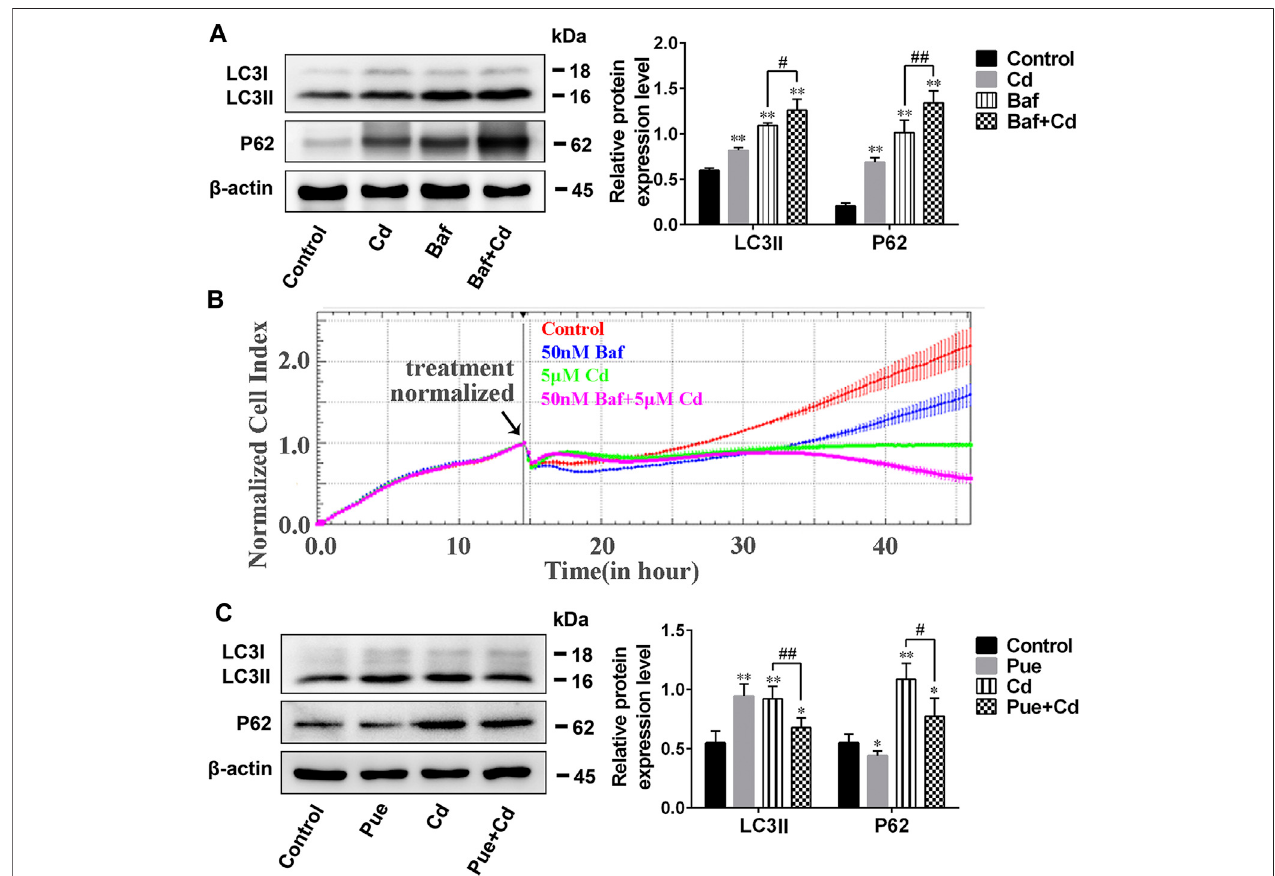
FIGURE3 | Pue alleviated Cd-induced autophagy blockade in AML12 cells. (A) Cells were treated withCd and Baf,alone or incombination, for 12 h, and then the levels of LC3 and P62 were detected using western blotting to re fl ect the changes in autophagic fl ux. Data are shown as the mean ± SD (n (cid:2) 4). Compared with the control group, ** p < 0.01. Compared with the Baf-treatment group, # p < 0.05, ## p < 0.01. (B) After treatment with Cd and/or Baf, the CI was monitored using RTCA to re fl ect the effect of autophagy blockade on Cd-induced cell injury. Error bars represents the standard deviation (n (cid:2) 3). (C) After treatment with Pue and/or Cd for 12 h, cells were collected and the levels of LC3 and P62 were analyzed using western blotting. β -actin was used as the reference protein, and representative protein bands are shown. Data are shown as the mean ± standard deviation (SD) (n (cid:2) 4). Compared with the control group, * p < 0.05, ** p < 0.01. Compared with the Cd- treatment group, # p < 0.05, ## p <